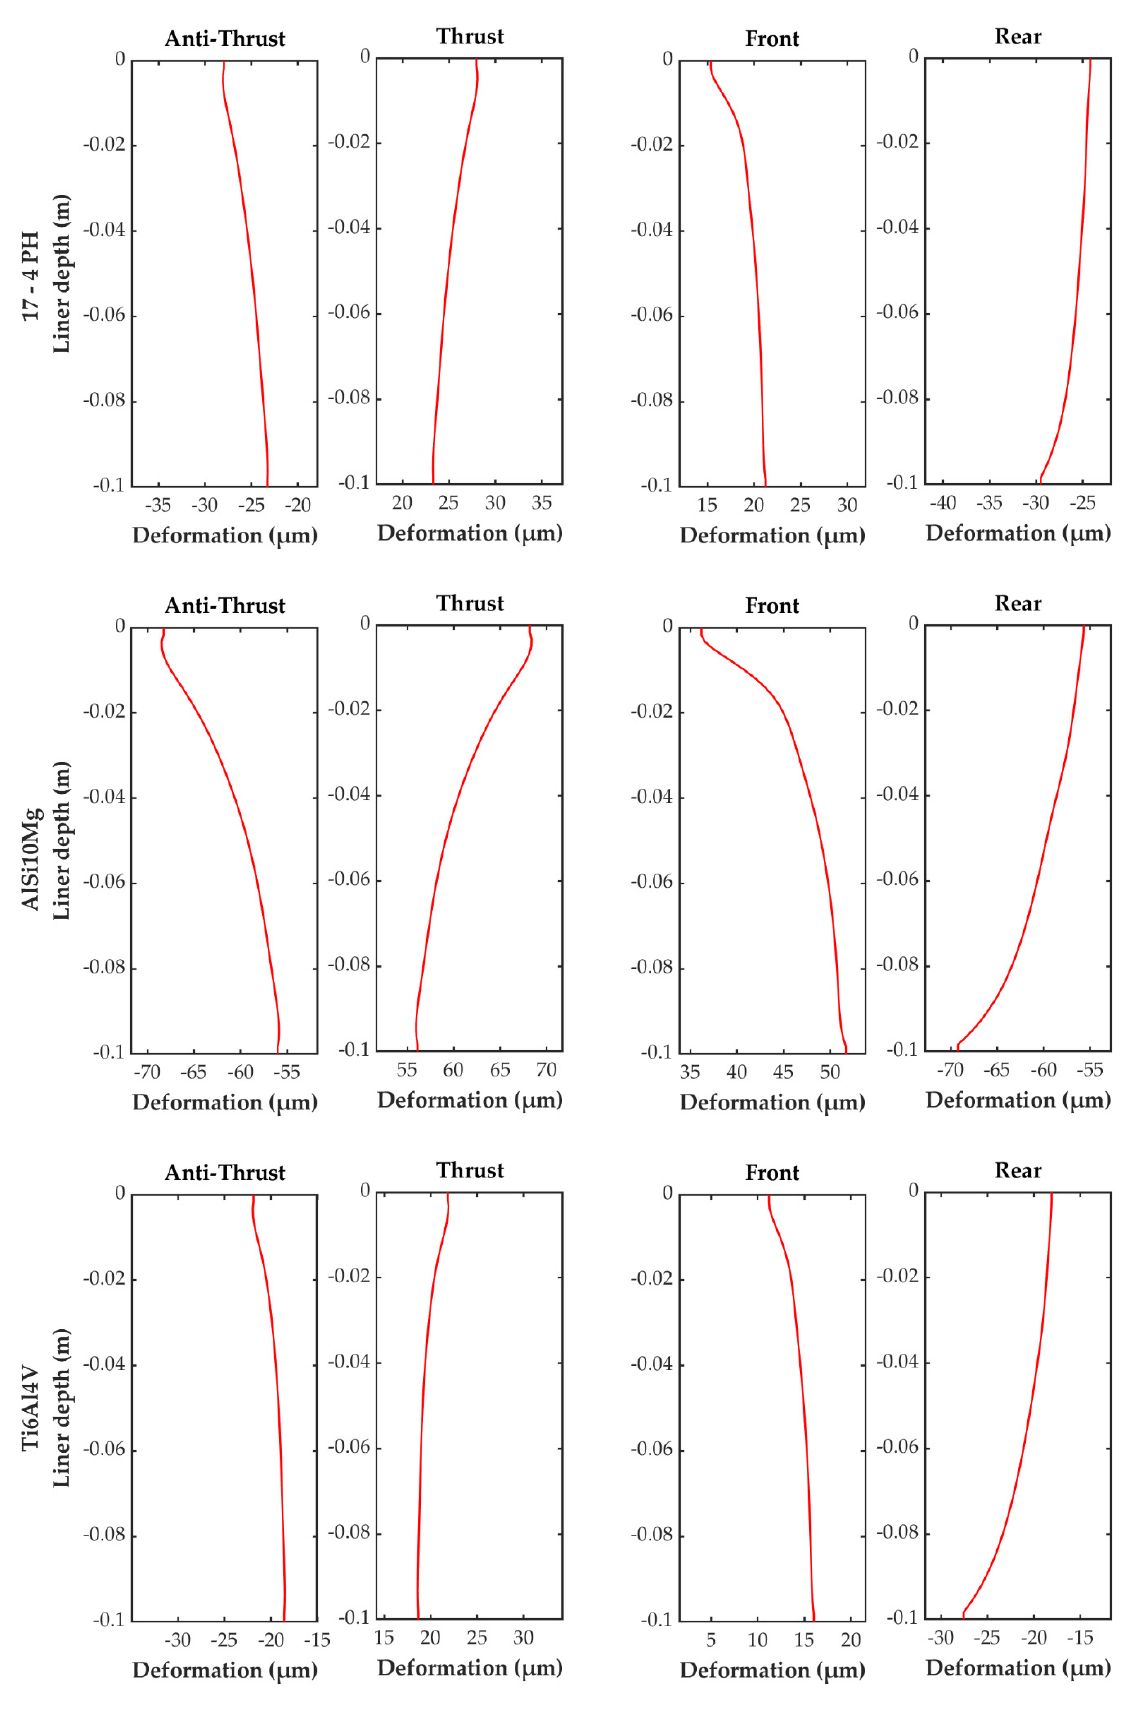
Figure 5. Bore deformation for grey cast iron and AM material.